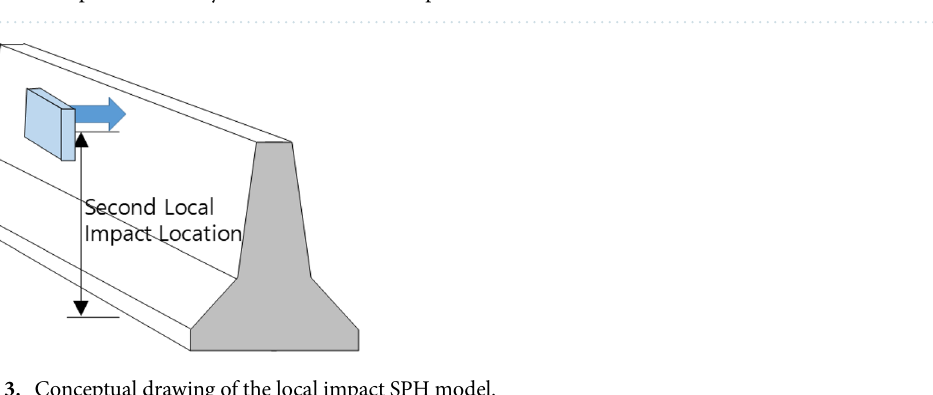
Figure 2. Comparison of analytical results with MRA prediction 11 .